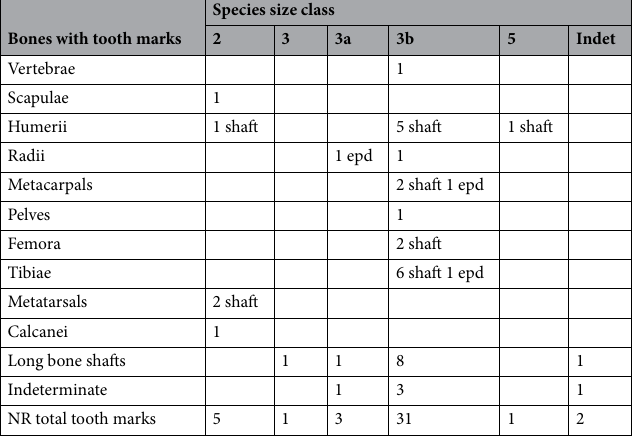
Table 3. Bones with tooth marks. Epd: Distal Epiphyses. Shaft: Diaphyses.